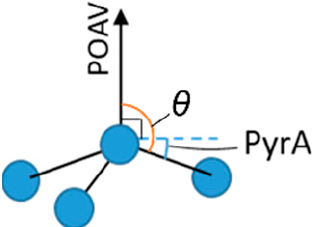
Figure 4. Schematic diagram of pyrA, defined as θ - π /2. POAV is the vector along the atom p z orbital and is defined as having a constant angle with all three carbon-carbon bonds. Blue spheres represent carbon atoms.